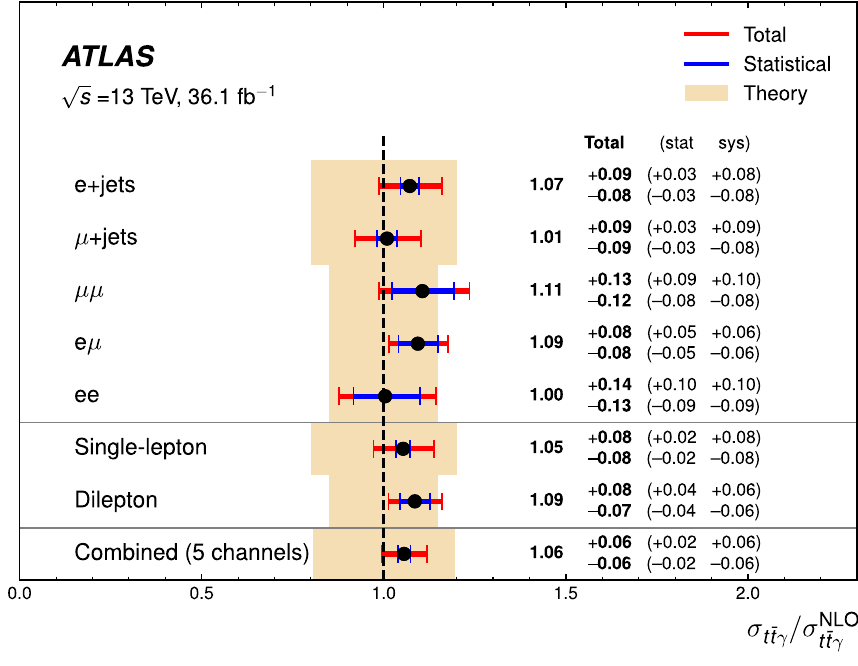
Fig. 8 The measured fiducial cross-sections normalized to their corresponding NLO SM predictions [10] for the five individual channels and for the single-lepton and dilepton channels, as well as the combination of all channels. The statistical uncertainties are the inner error bars, while the total uncertainties are the outer error bars. The NLO prediction for the inclusive fiducial cross-section is represented by the dashed vertical line, and the theoretical uncertainties are represented by the shaded bands